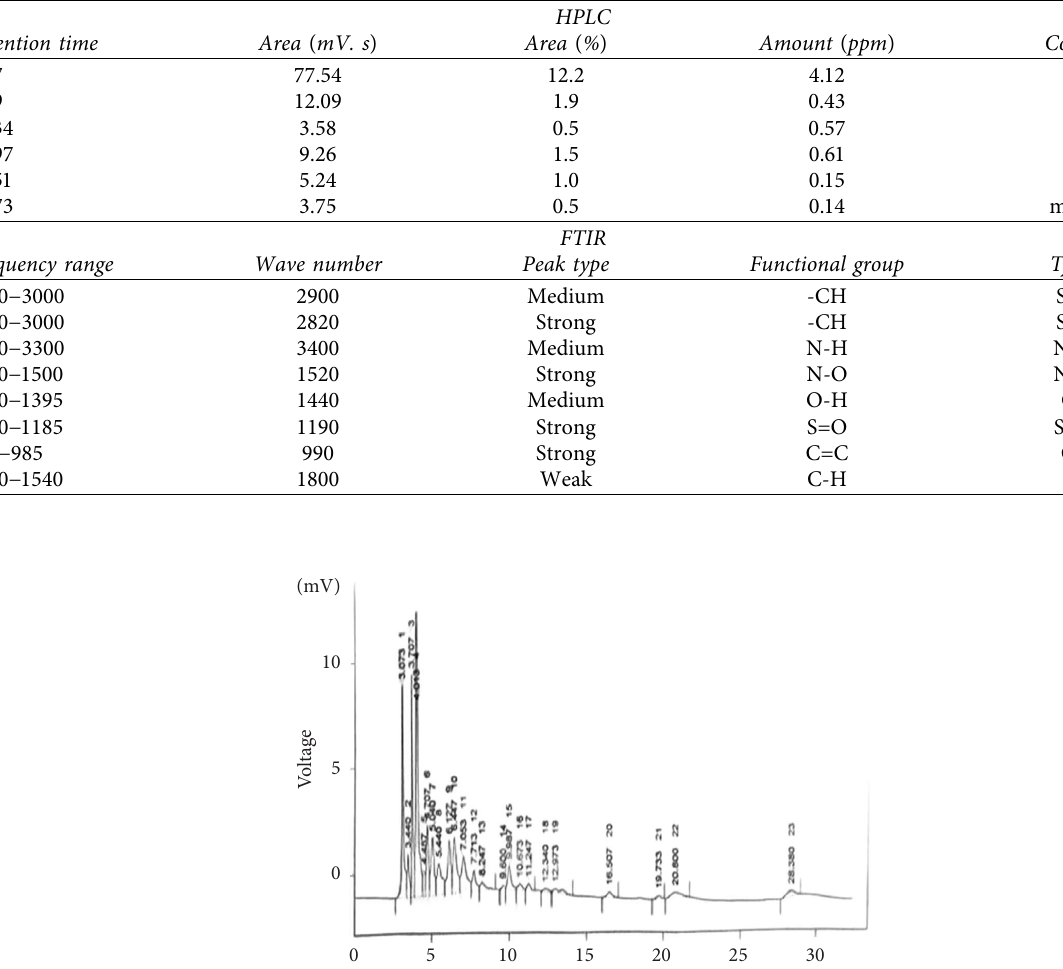
Table 2: Structural data analysis of Trigonella foenum-graecum leaves.